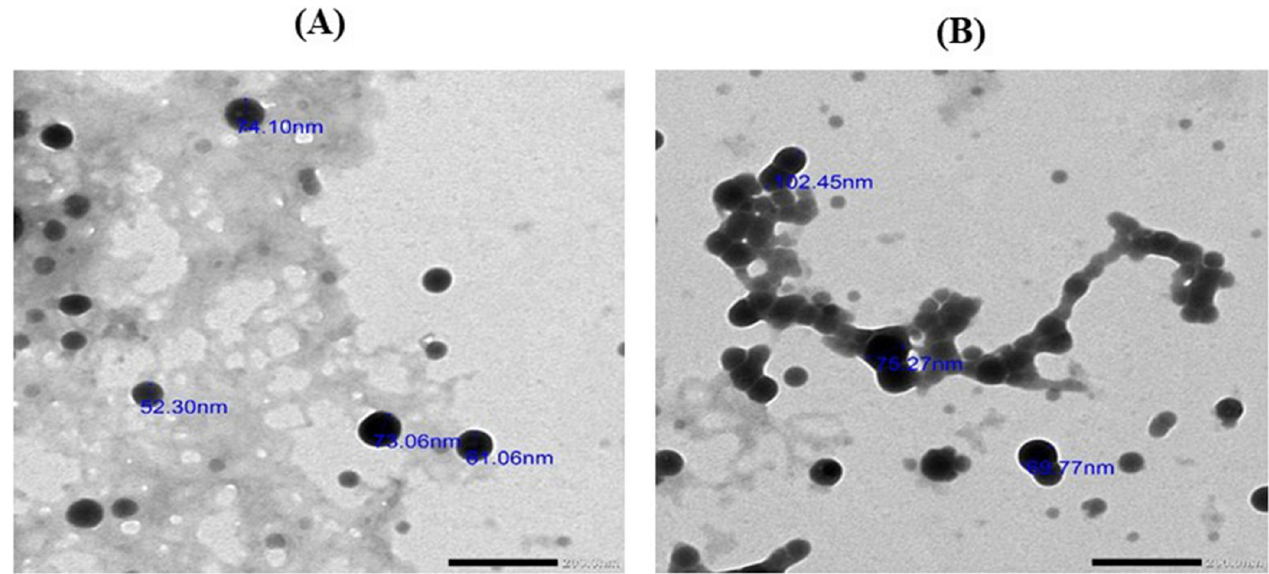
Fig 3. TEM micrographs of ( A ) fresh prepared targeted bee venom-CSNPs and ( B ) targeted bee venom-CSNPs after 30 days incubation in a buffer.